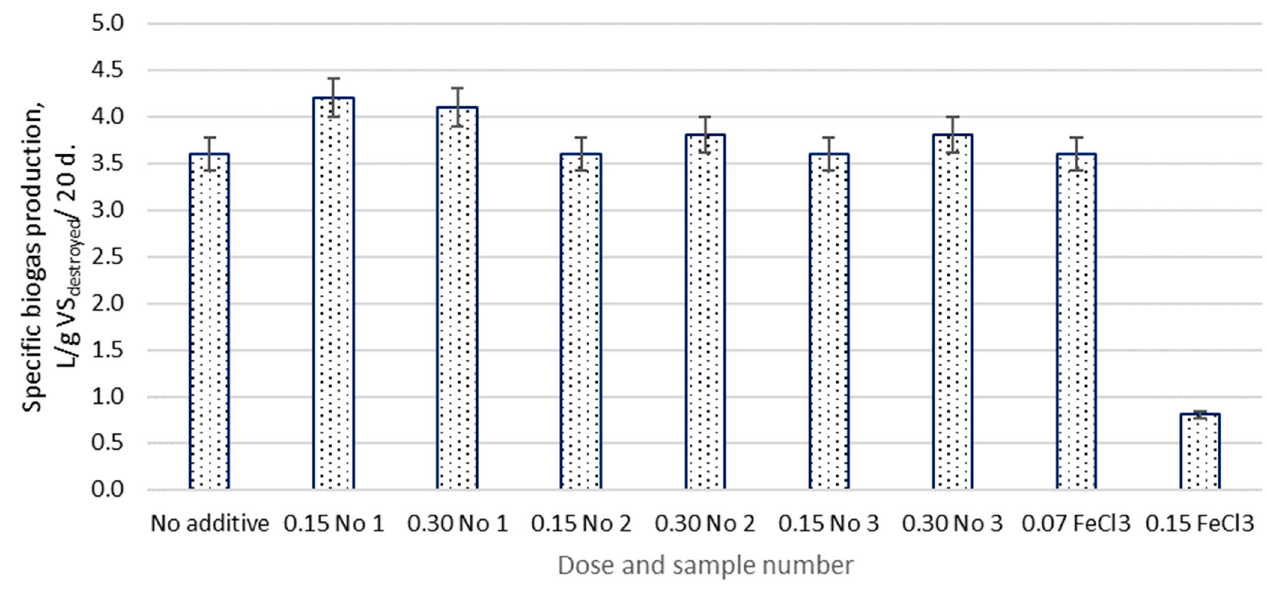
Figure 4. Average amount of biogas produced during 20 days of digestion and average content of methane in biogas. Doses of the additives are indicated in g/g SM/20 d.